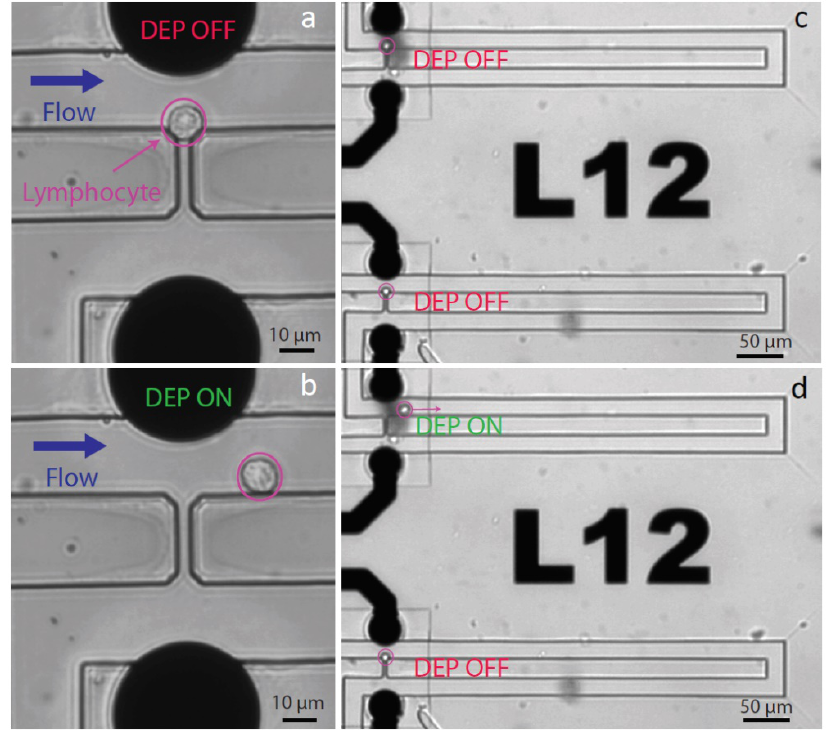
Figure 3. Selective single-cell retrieval. ( a,b ) A single lymphocyte can be trapped in the hydrodynamic constriction ( a ) and gently released (b) through application of negative DEP force activated by 10 Vpp voltage at 10 MHz . ( c , d ) The cell at the top is released, while the cell at the bottom is kept in the trap. The release is carried out with a 10 Vpp voltage at 10 MHz. A custom-made printed circuit board (PCB) enables the selective release of a single T lymphocyte. For more details, please refer to the Supplementary Material Video S3.